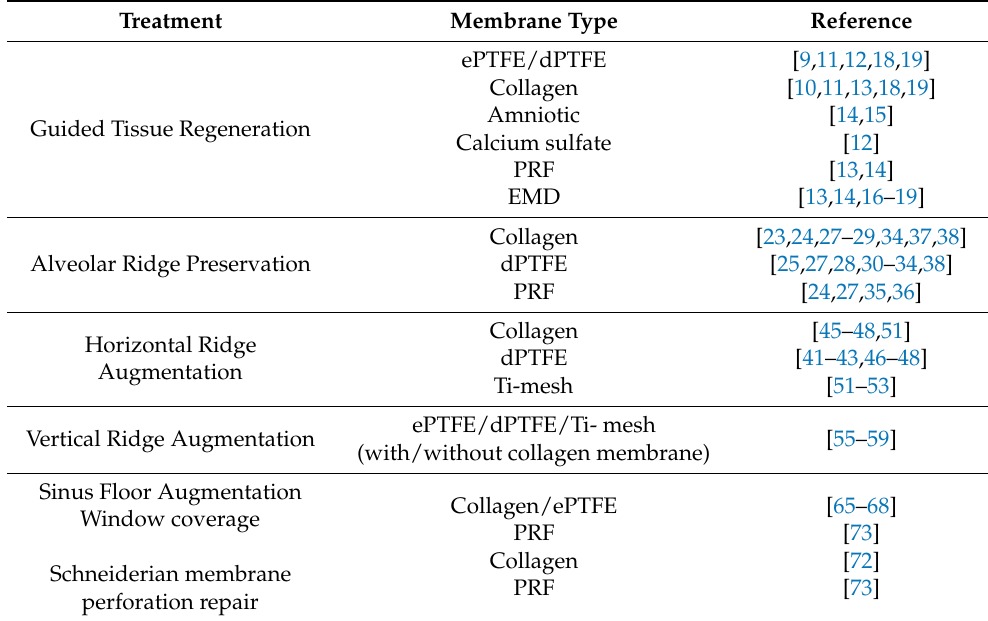
Table 2. Regeneration procedures and available membrane types and